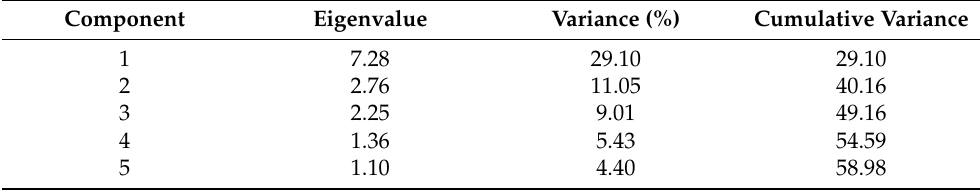
Table 4. Eigenvalue and percentage of variance explained by the extracted